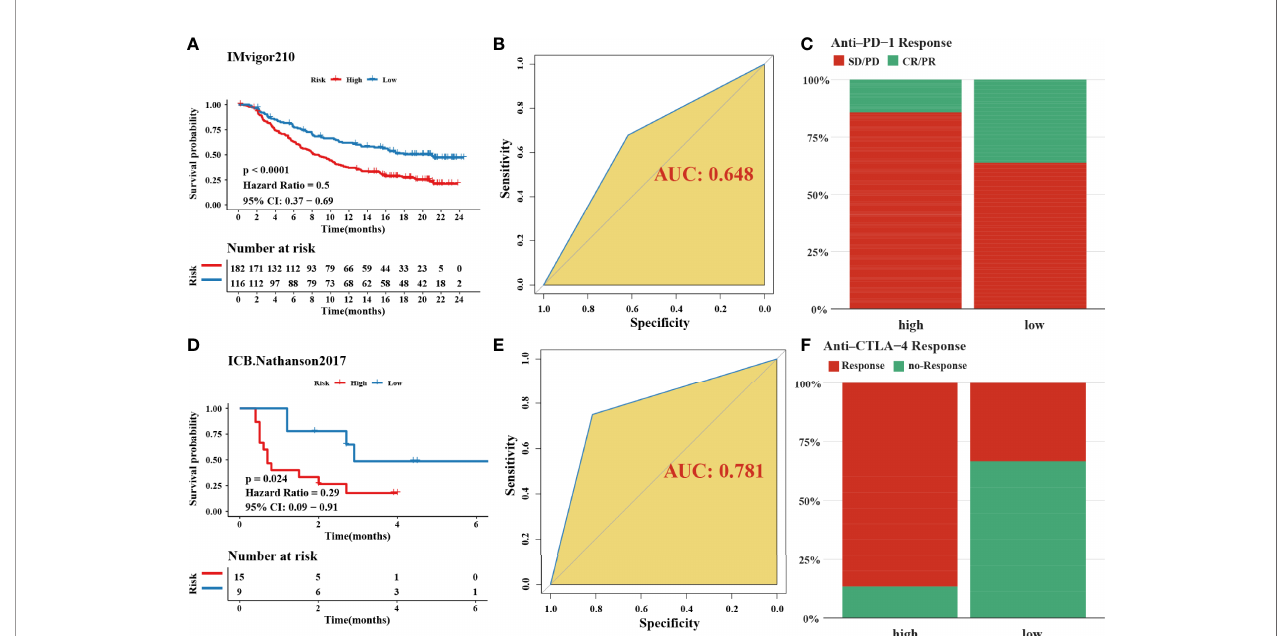
FIGURE 6 | Validation of signature through two immune-checkpoint blockade treatment cohorts. (A, D) Kaplan – Meier curves were plotted in (A) IMvigor210 cohort and (D) Nathanson2017 cohort to con fi rm the credibility of the signature. (B, E) the AUC in IMvigor210 cohort and ICB.Nathanson2017 cohort were 0.648 and 0.781, respectively. (C, F) The response of immune-checkpoint blockade treatment could be connected with high- and low-risk scores, especially in anti-CTLA-4 ( c 2 test). SD, stable disease; PD, progressive disease; CR, complete response; PR, partial response.